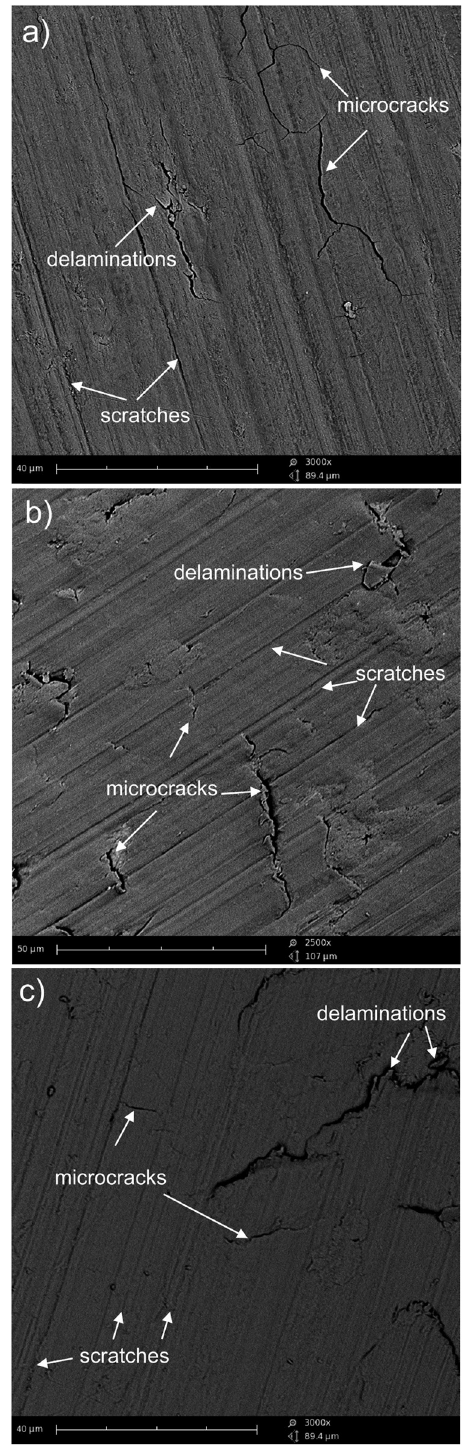
Figure 4: Representative SEM structures of wear tracks after tribo - logical tests under conditions of technically dry frictions of the following materials: ( a ) iglidur A180, ( b ) iglidur X, and ( c ) iglidur